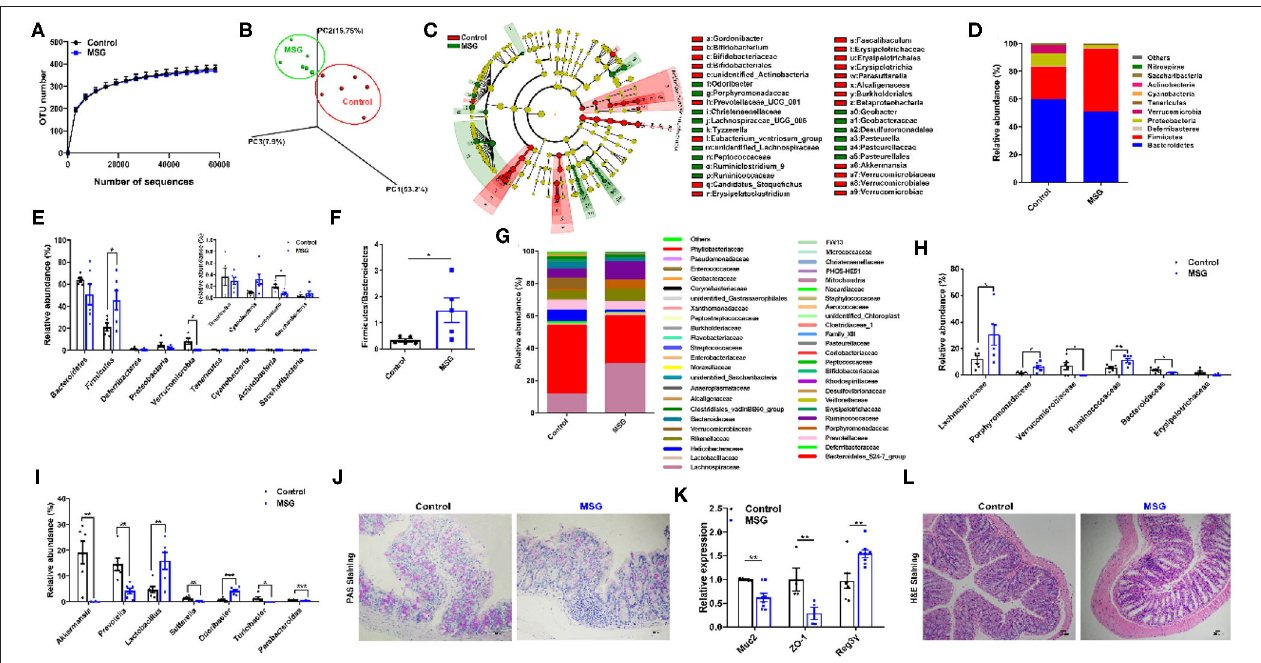
FIGURE 2 | MSG administration induces gut microbiota dysbiosis and damaged gut barrier. (A) OTU number accumulation analysis of 16S rDNA sequencing. (B) Weighted Unifrac analysis of microbiota in the control and MSG group. (C) Linear discriminant analysis effect size (LEfSe) of microbiota in the control and MSG group. (D) Microbiota composition and (E) relative abundances of microbiota at the phylum level. (F) The ratio of Firmicutes to Bacteroidetes . (G) Microbiota composition and (H) relative abundances of microbiota at the family level. (I) Relative abundance of flora at the genus level. (J) Periodic acid-schiff (PAS) staining of colon tissue. Scale bar: 20 µ m. (K) The gene expression of Muc2 , ZO-1, and Reg3 γ in colon. (L) H&E staining of colon tissue. Scale bar: 20 µ m. Data are presented as mean ± SEM, n = 6. Data were analyzed by one-way ANOVA followed by post-hoc LSD tests. * p < 0.05, ** p < 0.01, *** p <